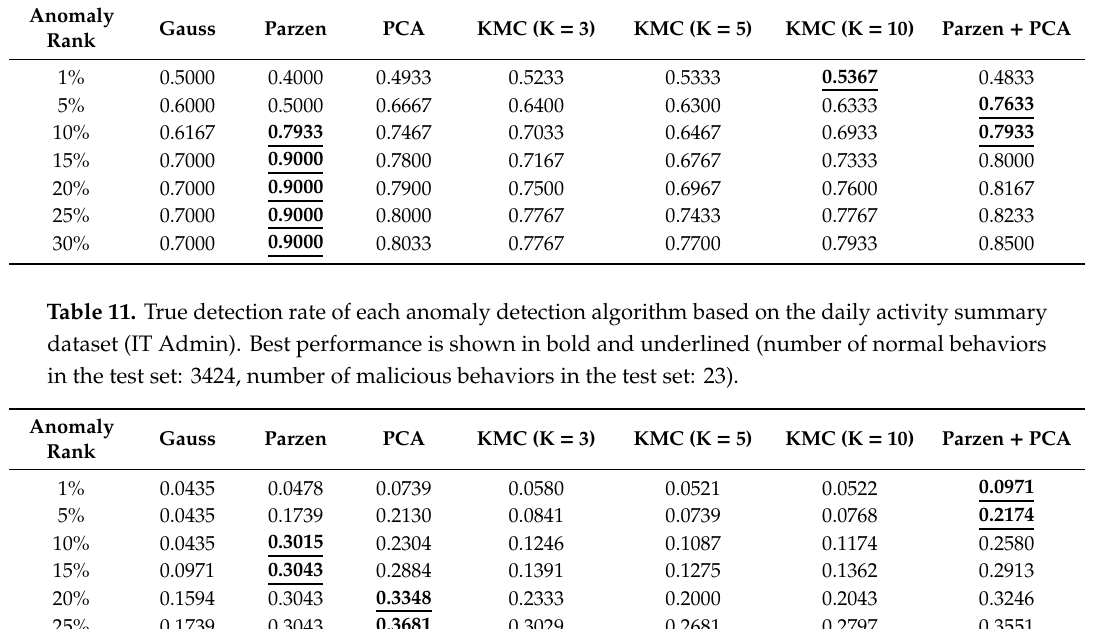
Table 10. True detection rate of each anomaly detection algorithm based on the daily activity summary dataset (Electrical Engineer). Best performance is shown in bold and underlined (number of normal behaviors in the test set: 14,120, number of malicious behaviors in the test set: 10).